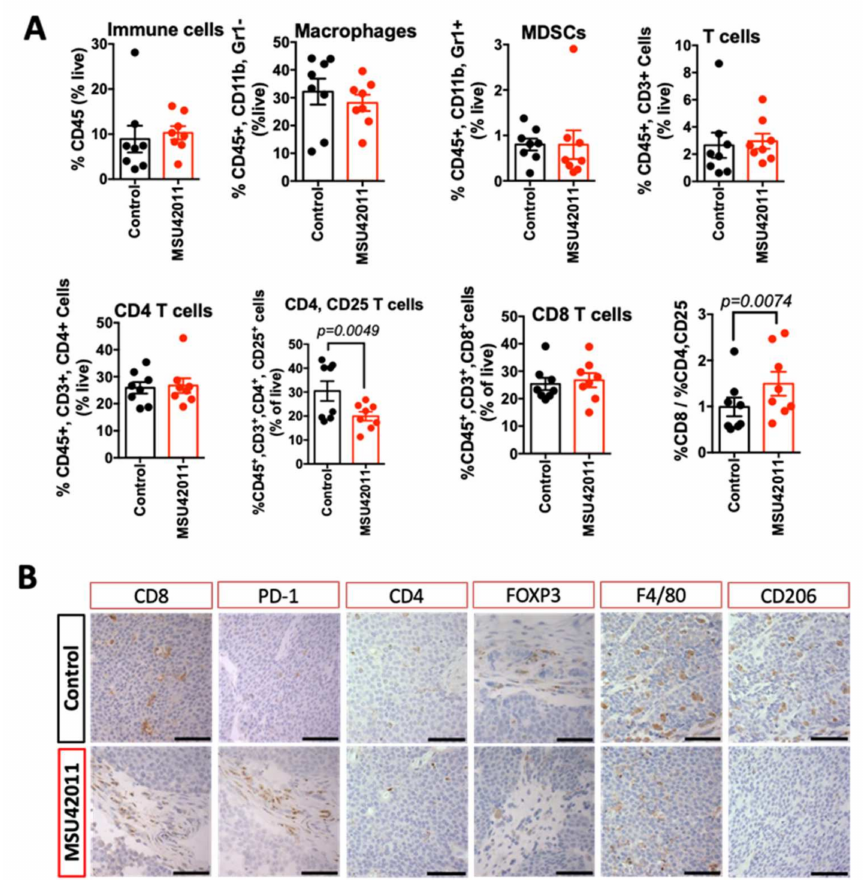
Figure 4. MSU42011 increases the percentage of activated CD8 cytotoxic T cells in the MMTV-Neu model of HER2-positive breast cancer. ( A ) Immune cell analysis by flow cytometry of whole tumor lysates ( n = 8/group) or ( B ) immunohistochemistry for tumors from MMTV-Neu mice treated for 10 days with MSU42011 or control diet. (scale bar 30 µ